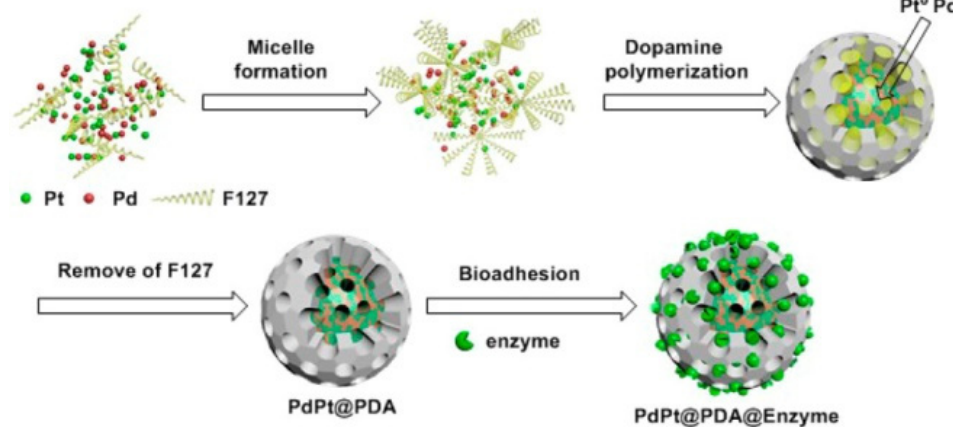
Figure 8. Preparation of a Pd-Pt/lipase core–shell catalyst [179]. Reprinted with permission from [179]. Copyright (2020) American Chemical Society.